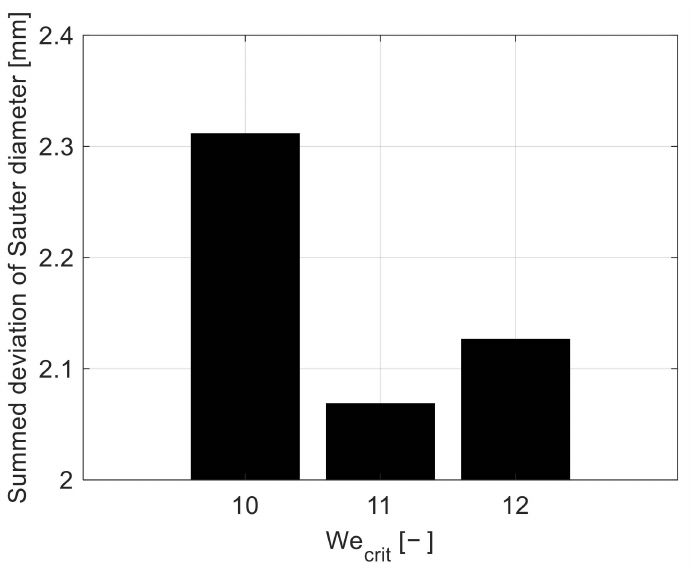
Figure 8. The summed deviation of the Sauter mean bubble diameter for different critical We numbers of the fitted model for Lehr et al. recreation. Table 3. Summary of all determined parameters to be able to implement the bubble breakage model of Luo et al. and Lehr et al. in